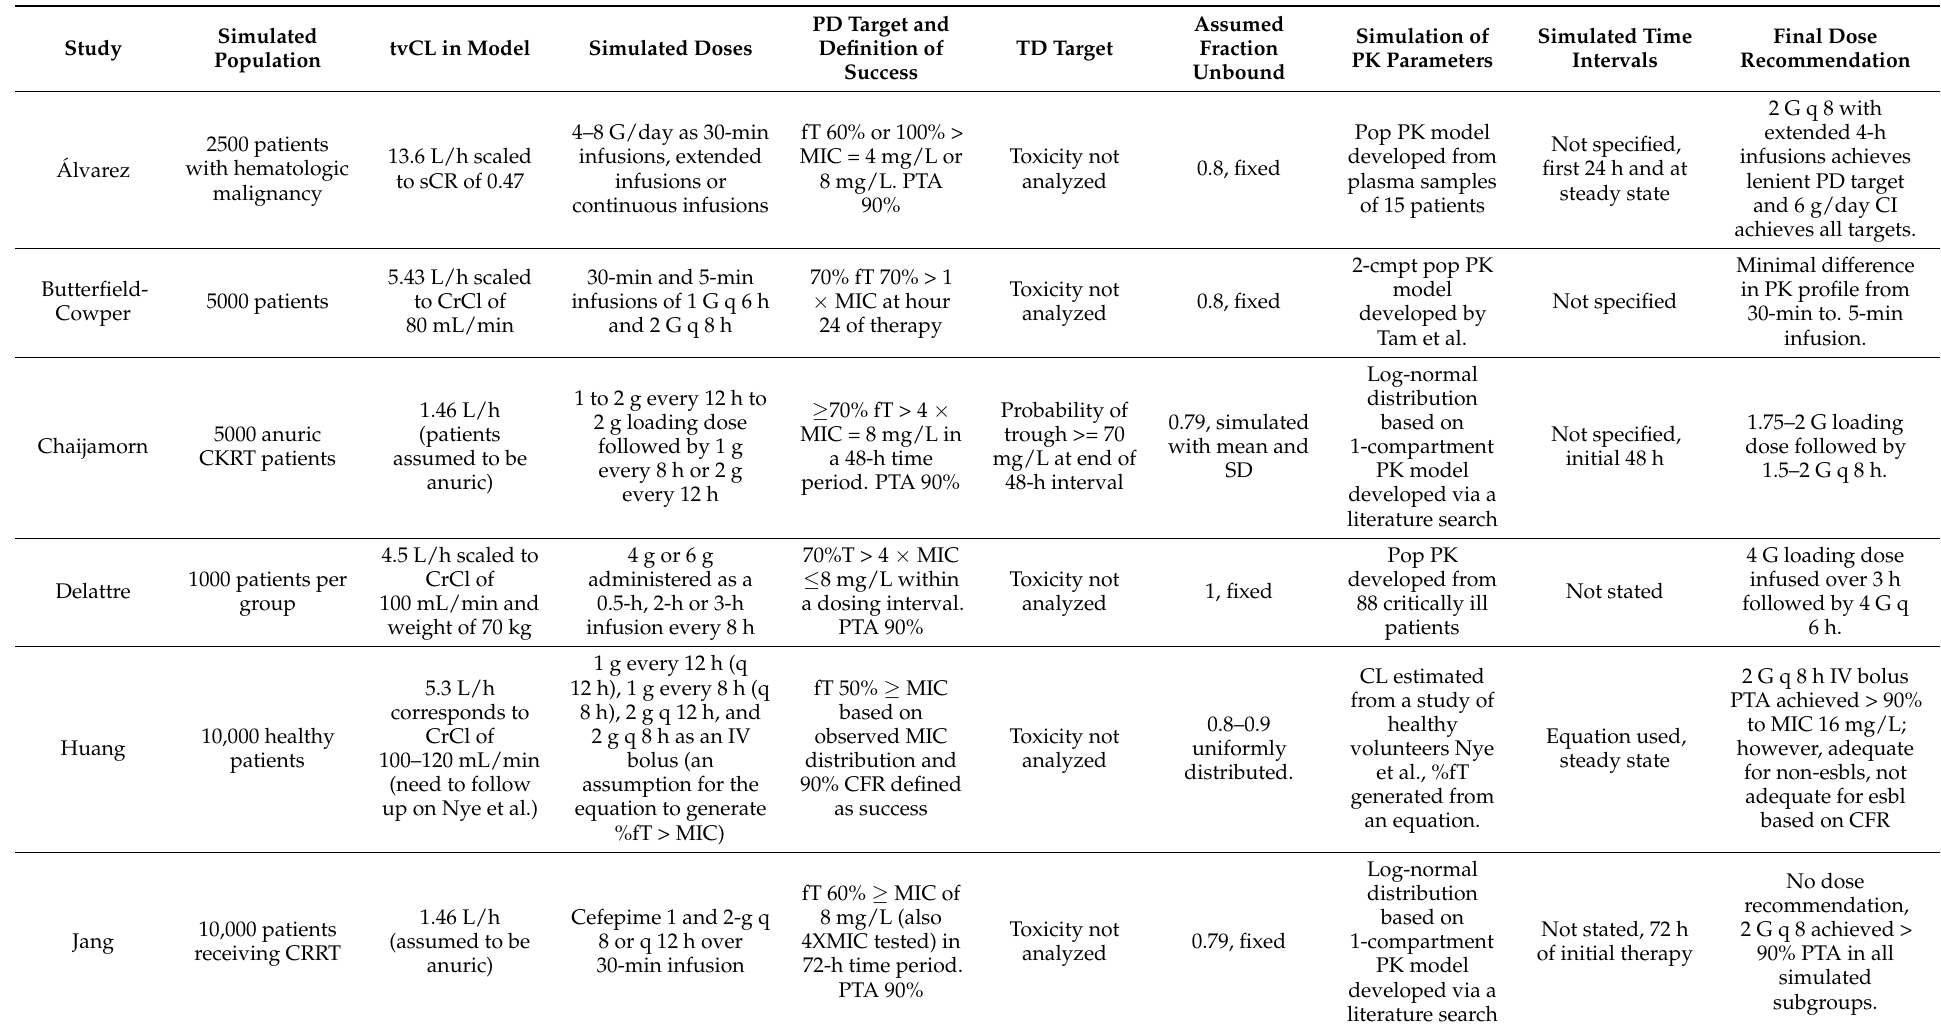
Table 1. Summary of studies included in mini review of using PTA to optimize cefepime